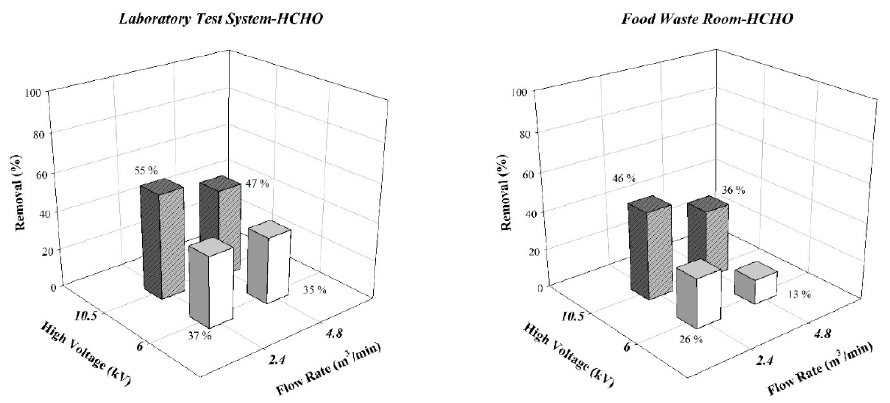
Figure 7. Experimental results of the formaldehyde.